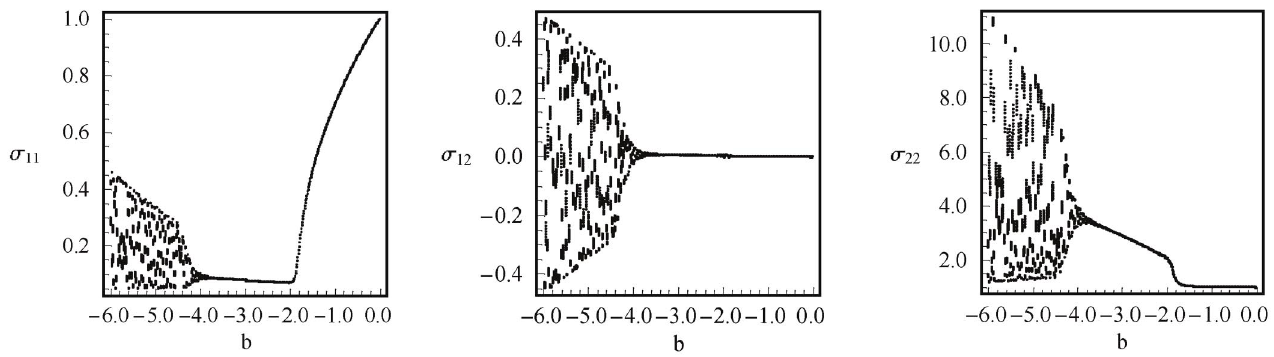
(cid:6) 0 : 085 and N s